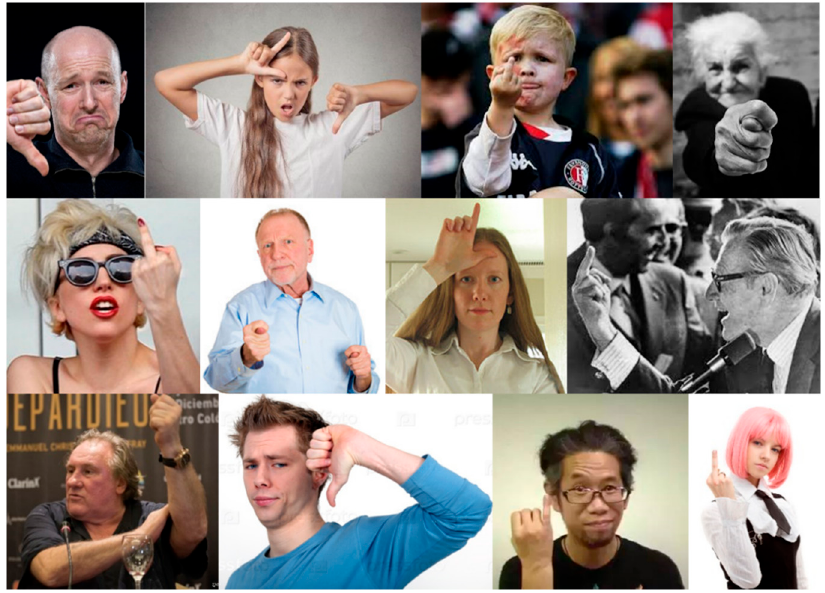
Figure 2. Discriminatory images obtained from the Internet.